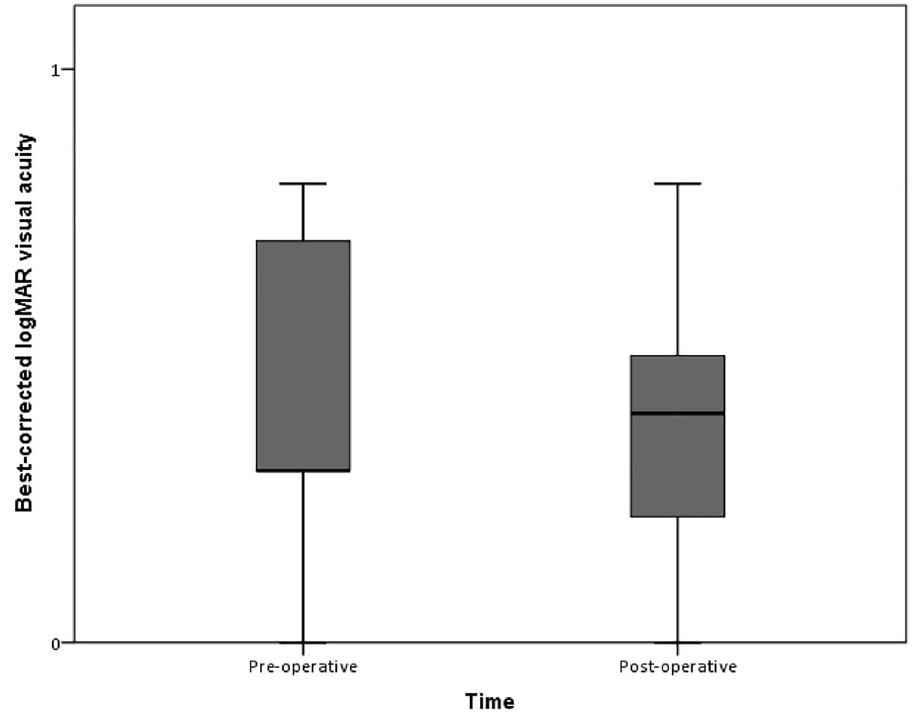
Figure 3. Box plot graphics show the similarity in best-corrected visual acuity (BCVA) at baseline (preoperative: mean logMAR BCVA: 0.43) and 3–6 months after surgery (postoperative: mean logMAR BCVA: 0.37). Middle line represents the median, the square represents the mean, the 25th and 75th percentiles determine the box, and the 5th and 95th percentiles determine the